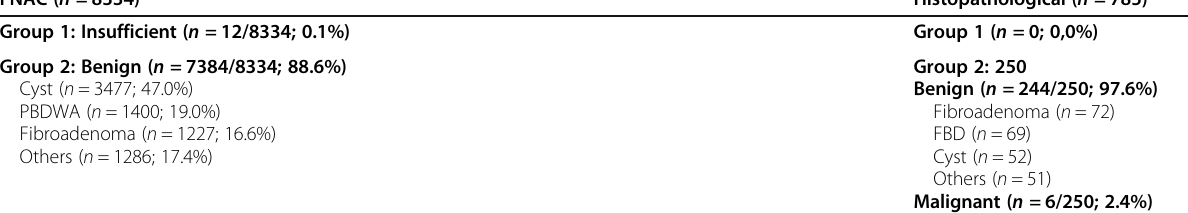
Table 1 Number of cases in each group and the main FNAC and histopathological diagnoses FNAC ( n = 8334) Histopathological ( n =